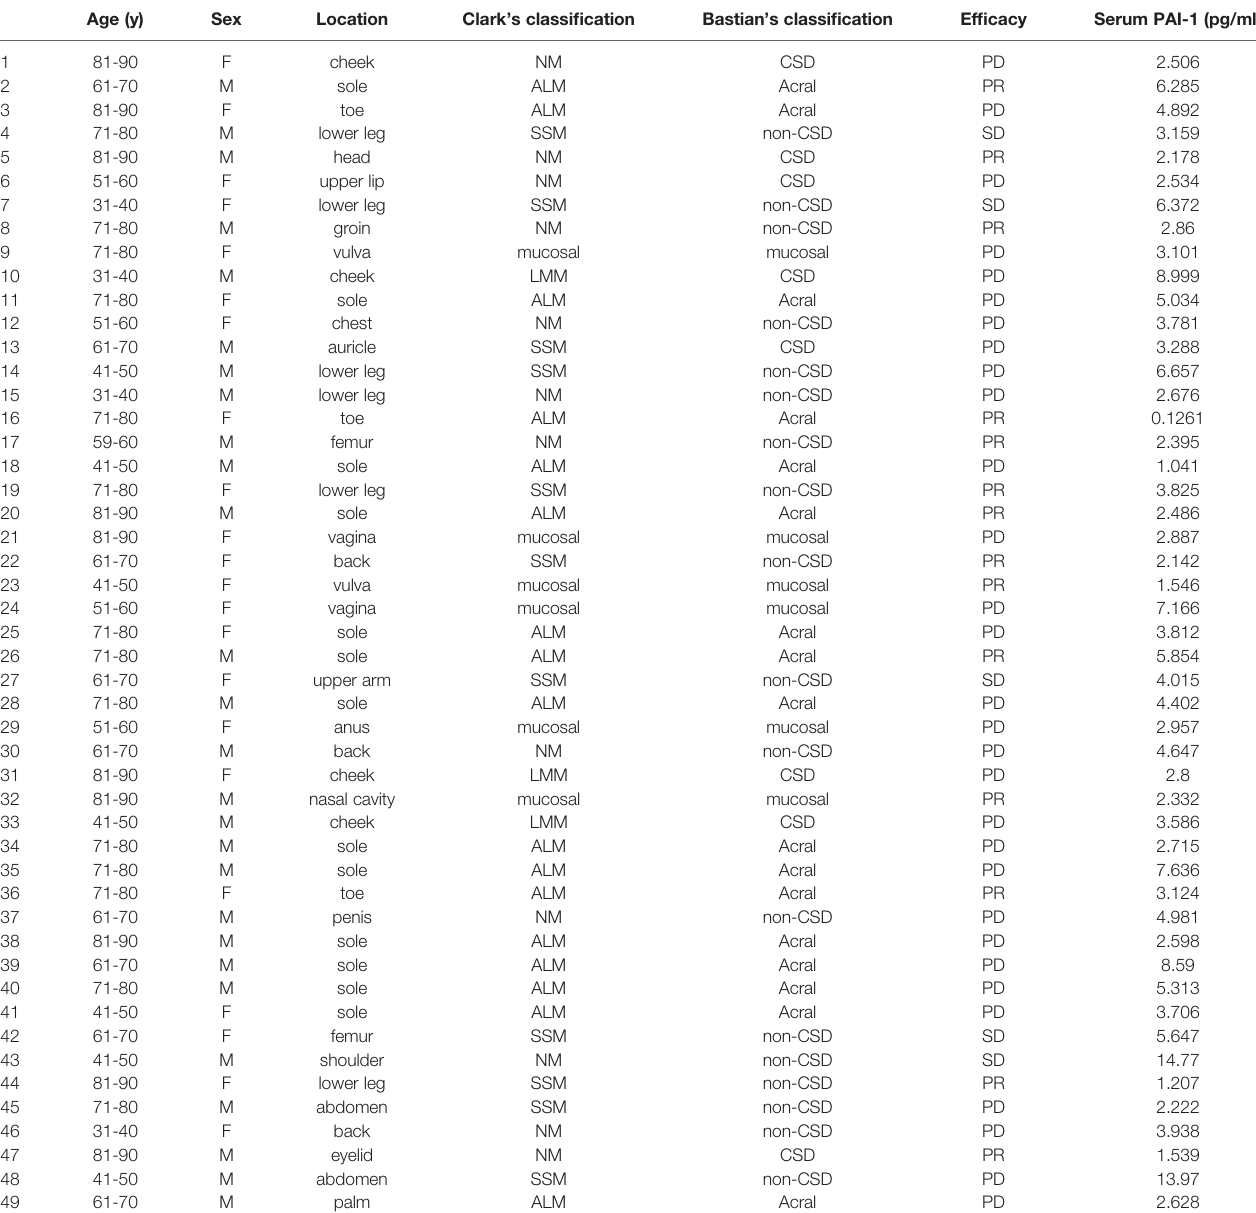
TABLE 2 | Characteristics and serum levels of PAI-1 in 49 patients with advanced melanomas. Age (y) Sex